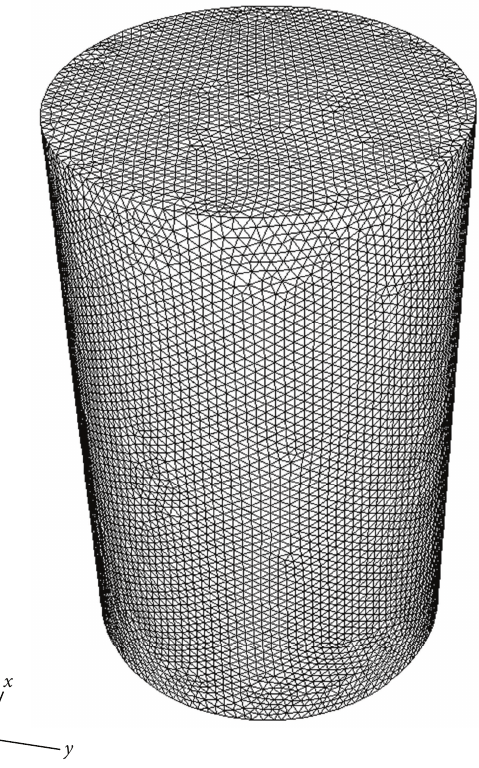
Figure 5: Homogeneous unstructured grid with tetrahedral ele- ments.